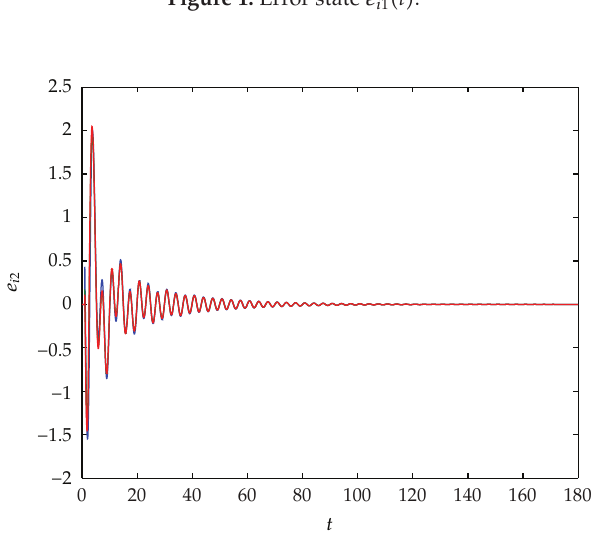
Figure 1: Error state e i 1 (cid:6) t (cid:7) .